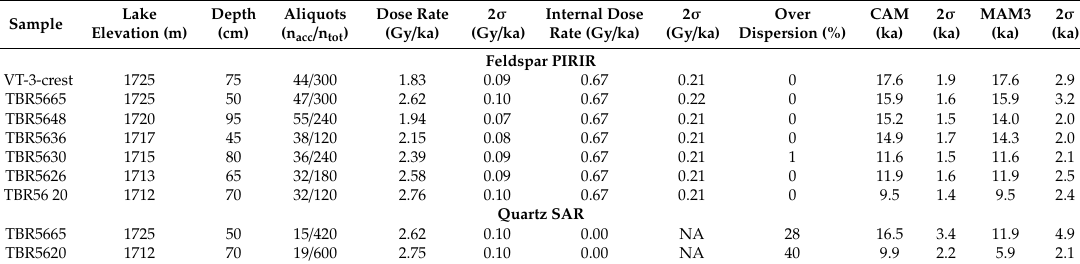
Figure 11. Results of luminescence dating of samples from the Lake Clover beach ridges. Ages denoted as “F” were determined with single grain analysis of K-feldspar using the pIRIR SAR protocol. The two ages denoted as “Q” were determined with the SAR protocol on quartz. “n” indicates the number of accepted discs considered in each age. Ages are presented in ka with 2- σ errors. All results were calculated using the central age model [26], shown in Table 2. Table 2. Summary of Luminescence Results.